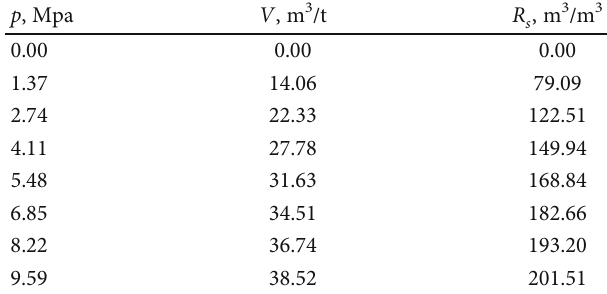
Table 2: Adsorbed gas volume and dissolved gas-oil ratio in shale. p ,